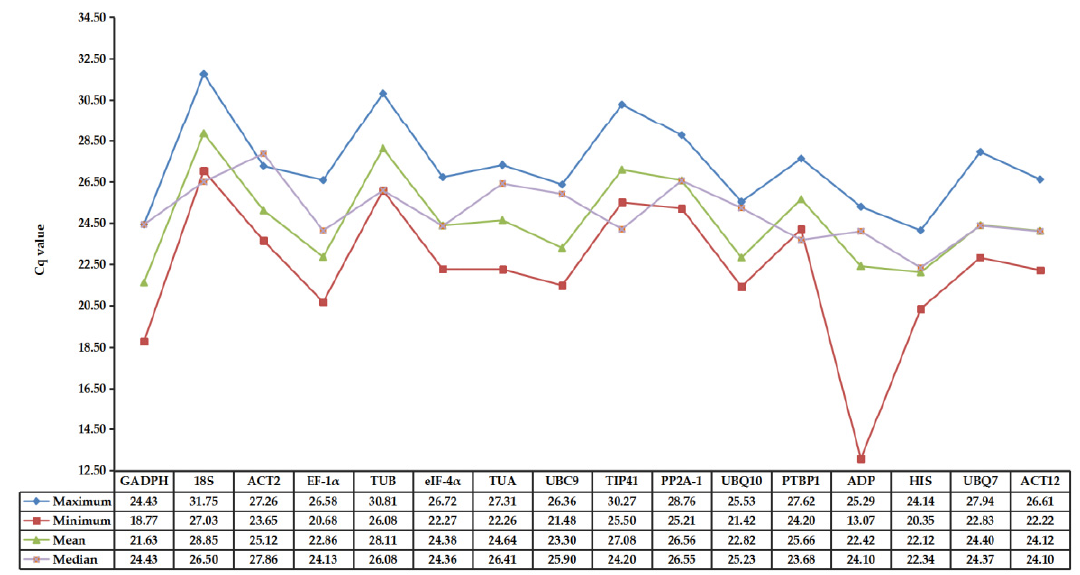
Figure 2. Maximum, minimum, mean, and median Cq values of the 16 candidate reference genes across all samples.